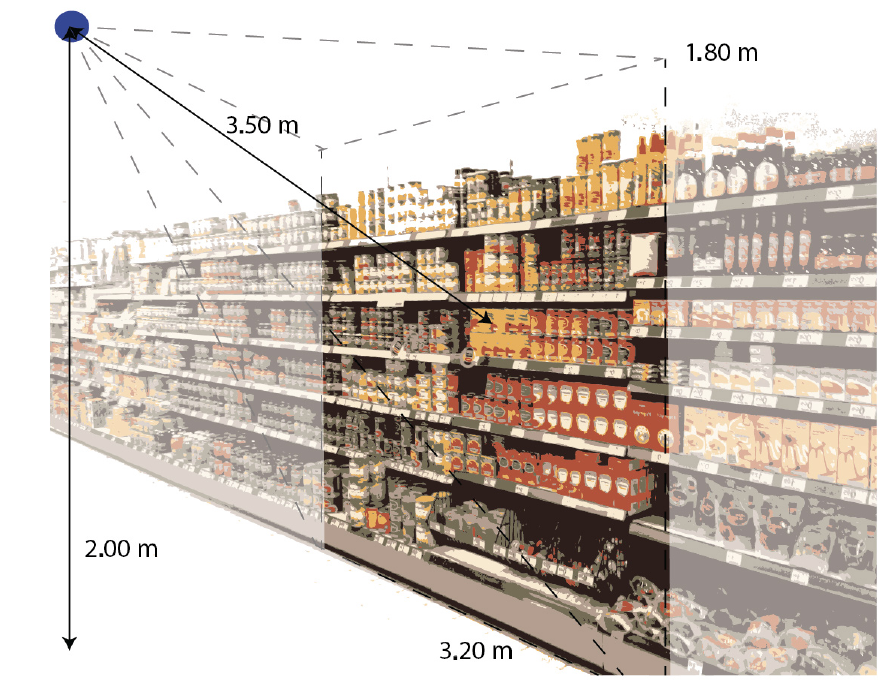
Figure 9. Representation of the experimental